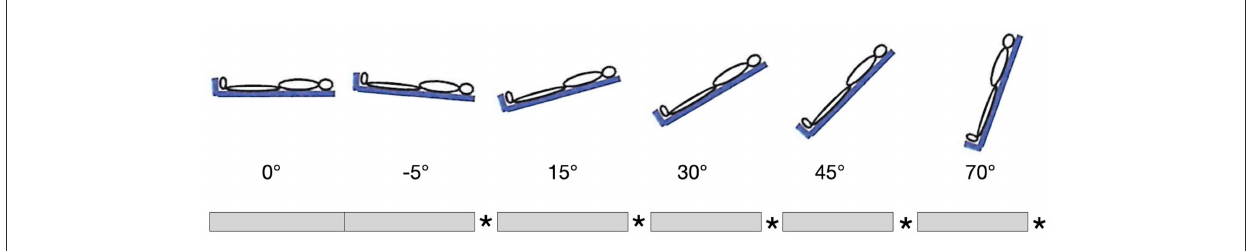
FIGURE1 Verticalization protocol. Gray bars represent 3–5min at indicated position, stars represent 3–5min at 0 ◦ . The first 3–5min at 0 ◦ were taken as baseline.